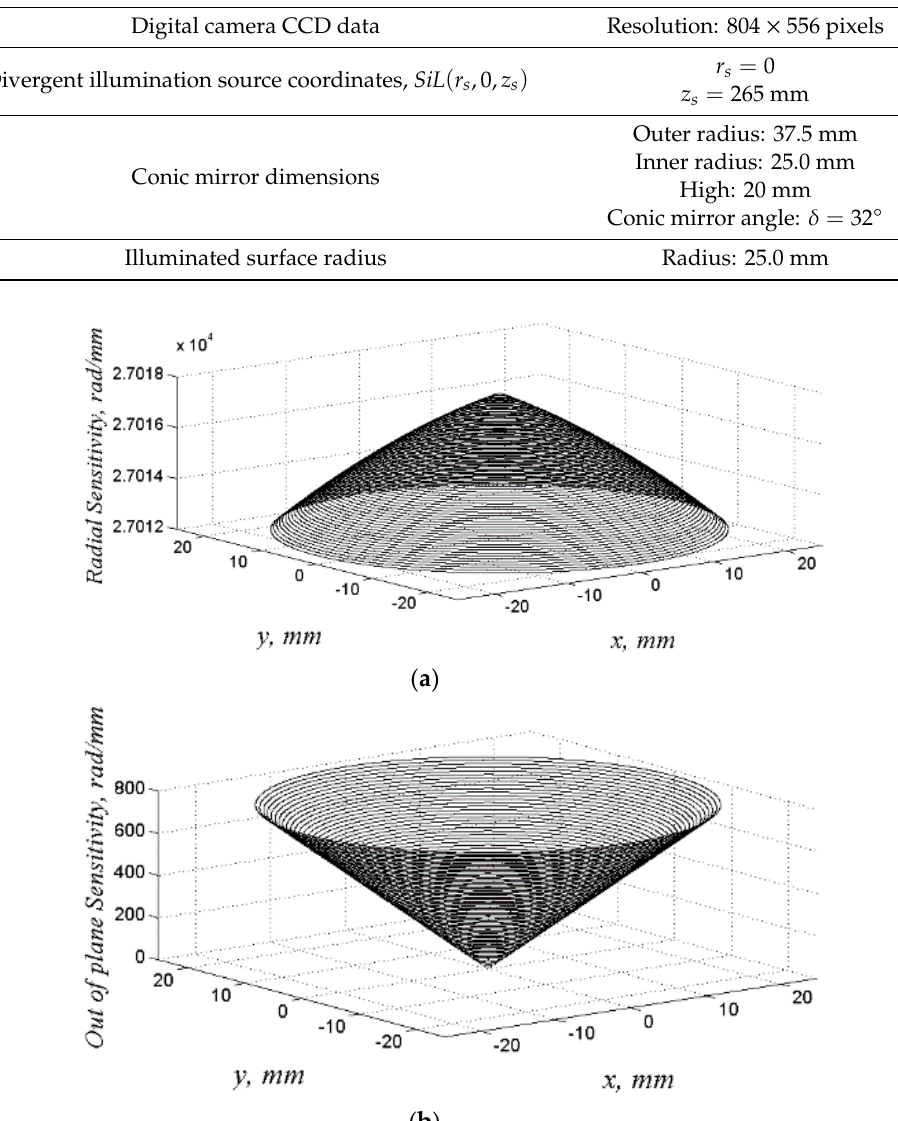
Figure 3. Radial component in-plane ( a ) and out-of-plane ( b ) of the sensitivity vector.